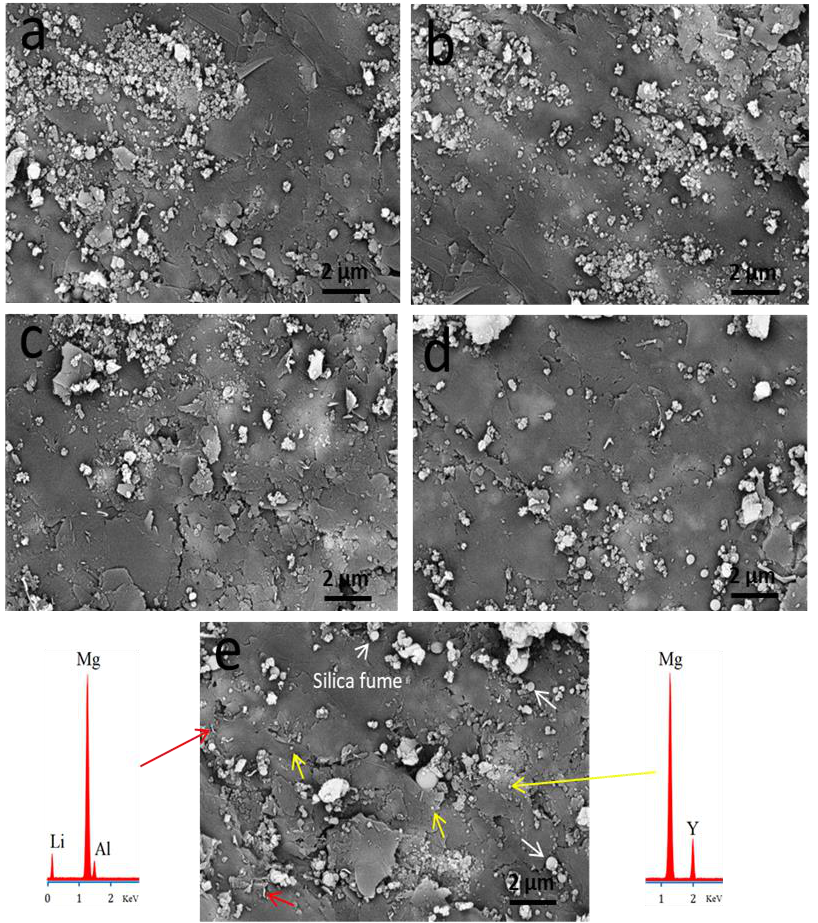
Figure 8. SEM images of sintered ( a ) FGC-0, ( b ) FGC-1, ( c ) FGC-2, ( d ) FGC-3, and ( e ) FGC-4 and their corresponding EDX pattern.